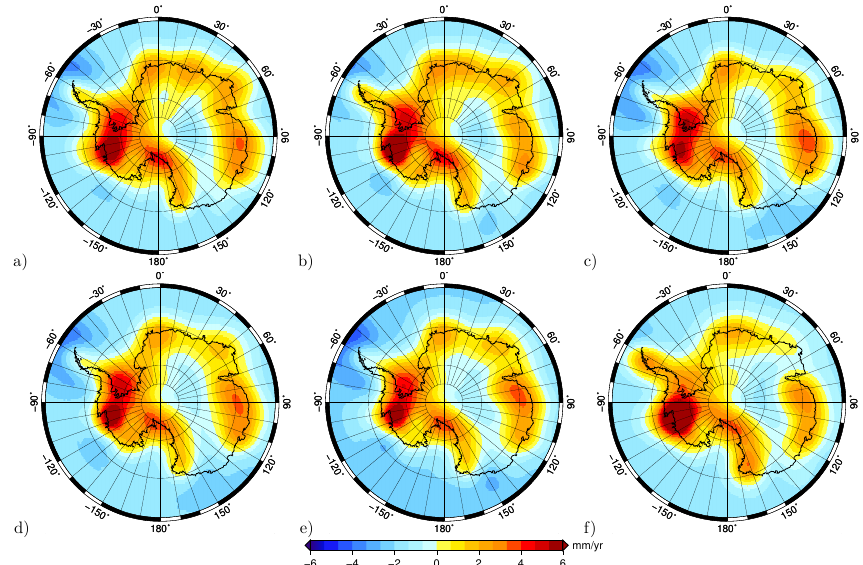
Fig. 8. Estimated empirical GIA vertical rates computed from the combination approach of Eq. (3) and using the following GRACE solutions: